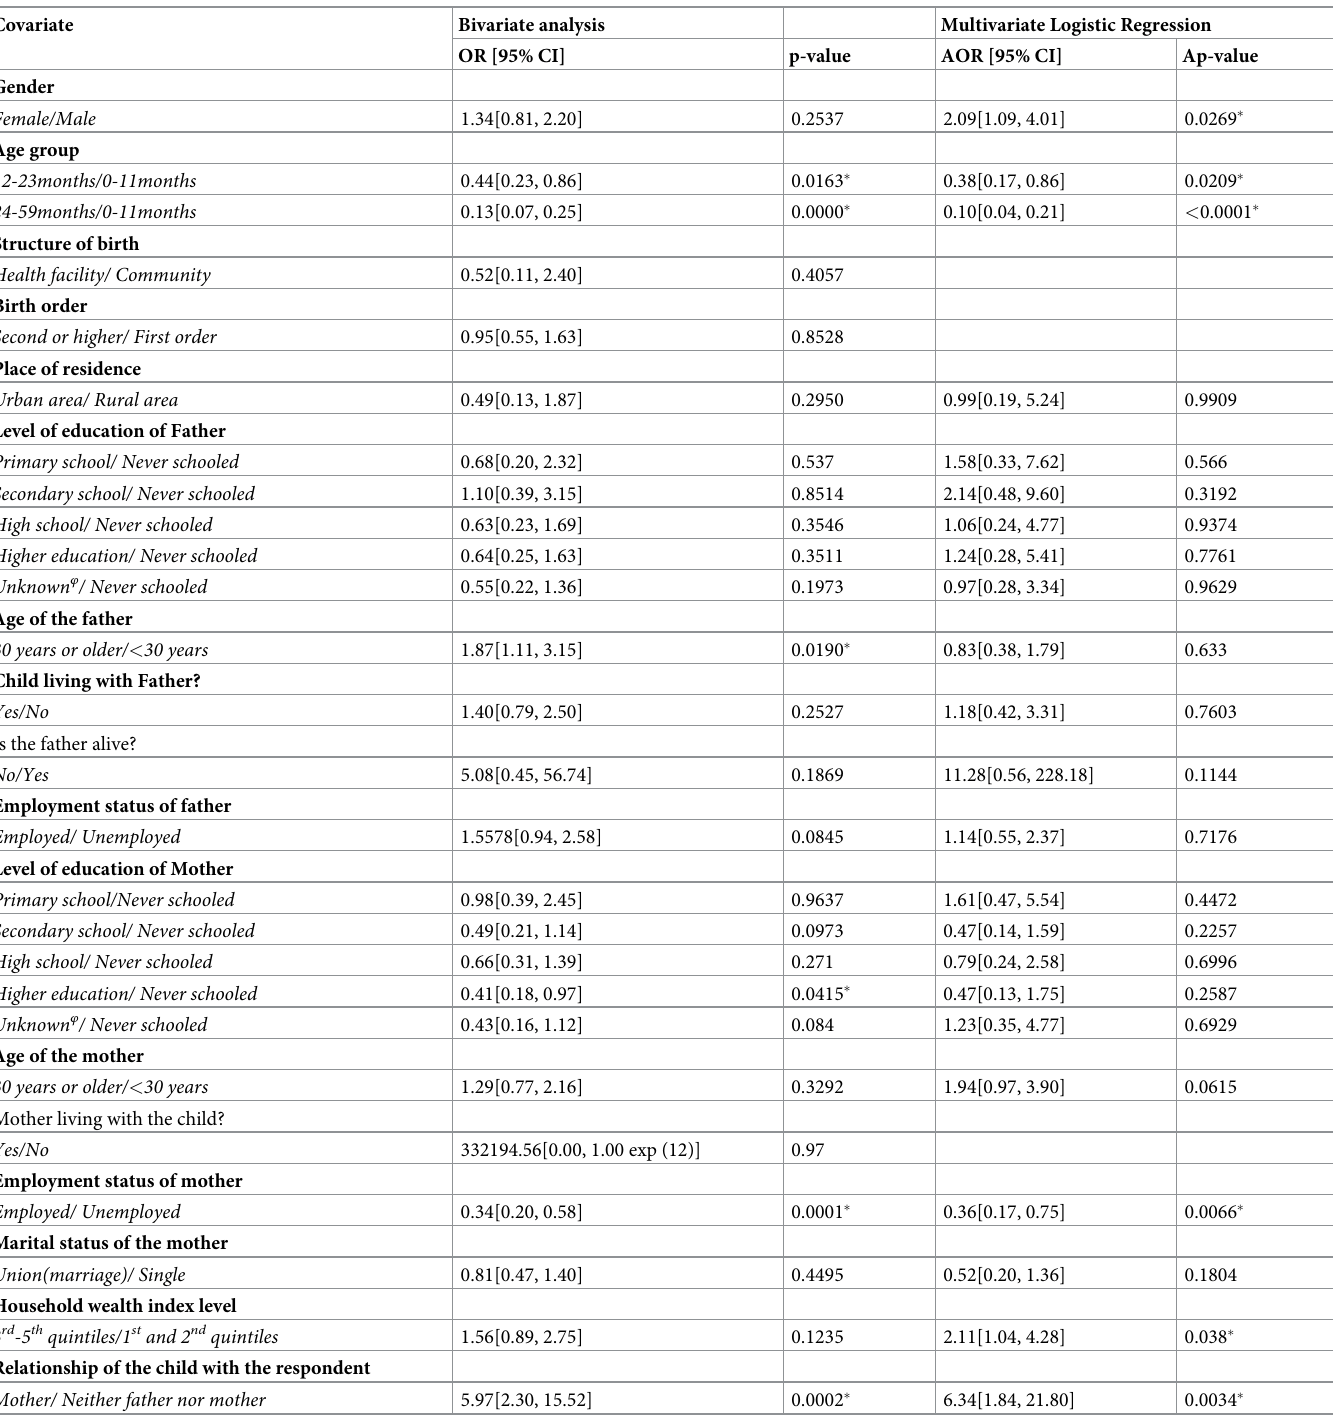
Table 1. Assessment of potential factors associated with vaccination card retention in